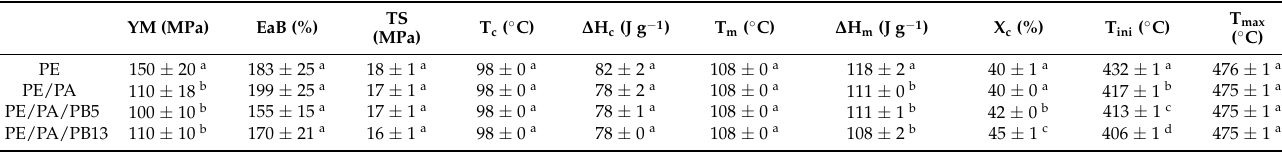
Table 2. The results obtained for thermal (mean ± SD, n = 3) and mechanical properties (mean ± SD, n = 5) of the studied films. Different superscripts within the same column indicate statistically significant different values ( p < 0.05). YM